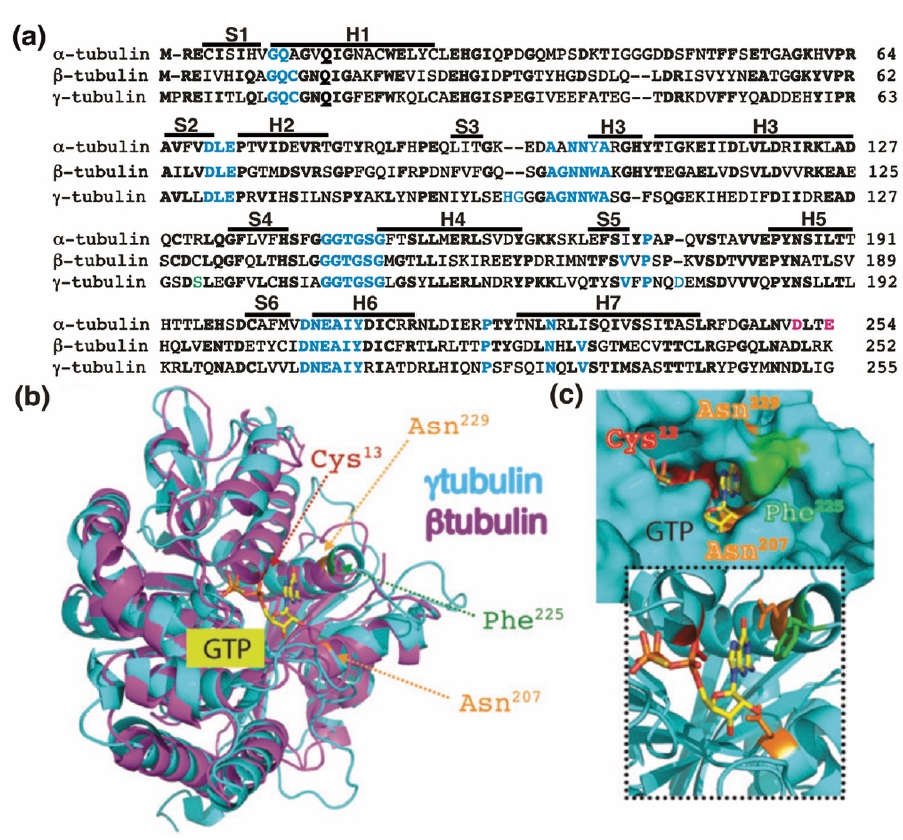
Figure 1. The GTP-binding domain. ( a ) Sequence alignment of the N-terminal GTP-binding domain (enclosing the first five α-helices and six parallel β-strands [16]) and nearby regulating sequences of human α-tubulin (residues 1–254; GenBank: AAA91576), β-tubulin (residues 1–252; GenBank: AAB59507.1), and γ-tubulin (residues 1–255; GenBank: AAV38734.1). Bold and magenta letters indi- cate identical and essential residues for the β-tubulin-mediated hydrolysis of GTP, respectively [21]. Residues involved in GTP binding are blue. Ser 131 is labeled green. Helices (H) and strands (S) are indicated. ( b ) The known three-dimensional structures of β-tubulin (magenta) and γ-tubulin (cyan) with a view down the GTP-binding pocket, highlighting Cys 13 , Asn 207 , Phe 225 , and Asn 229 . ( c ) The mo- lecular surface of the GTP/GDP-binding pocket of γ-tubulin is displayed, and GTP is shown in a stick representation. The inset (dashed lines) shows GTP together with the protein with only the side-chains of Cys 13 , Asn 207 , Phe 225 and Asn 229 displayed. ( b , c ) Reproduced with permission from B.O. Villoutreix; published by American Association for Cancer Research, 2015 [30].